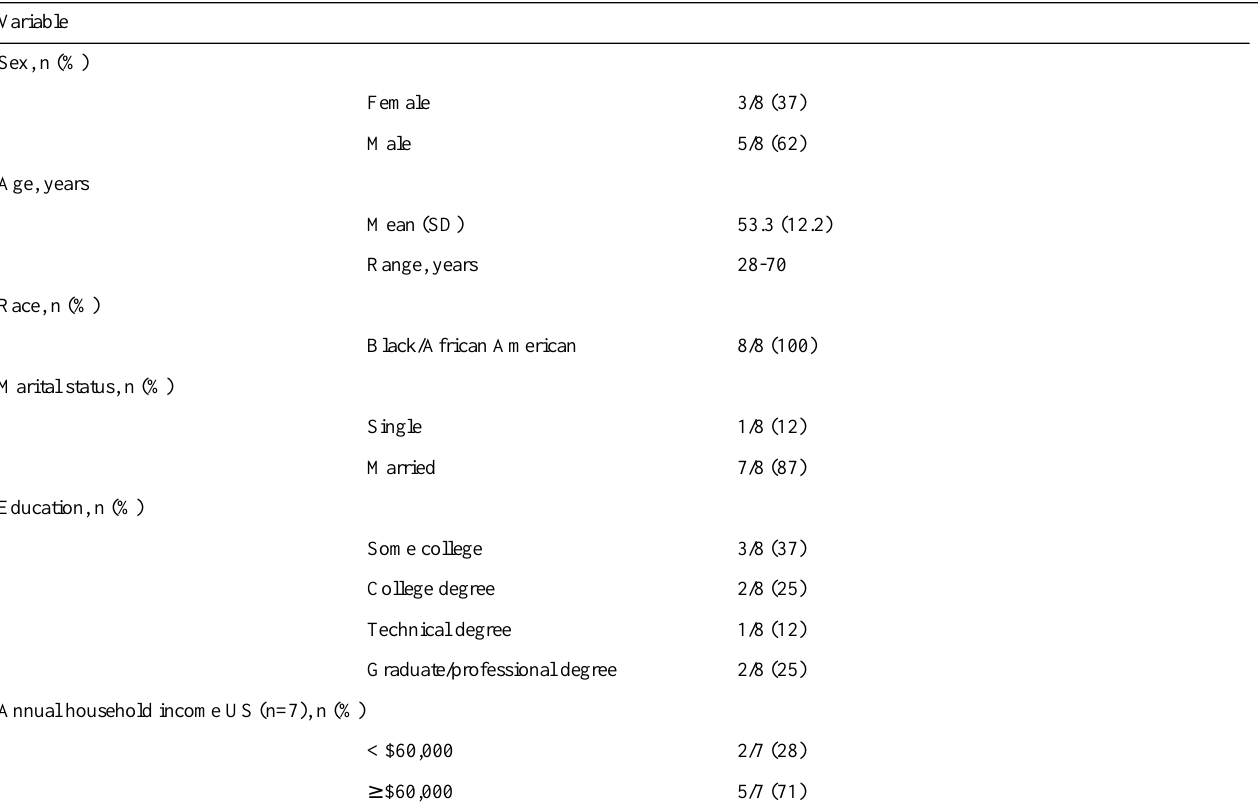
Table 1. Participant baseline characteristics in the CV Health and Needs Assessment Qualitative Study, 2014 (n=8).